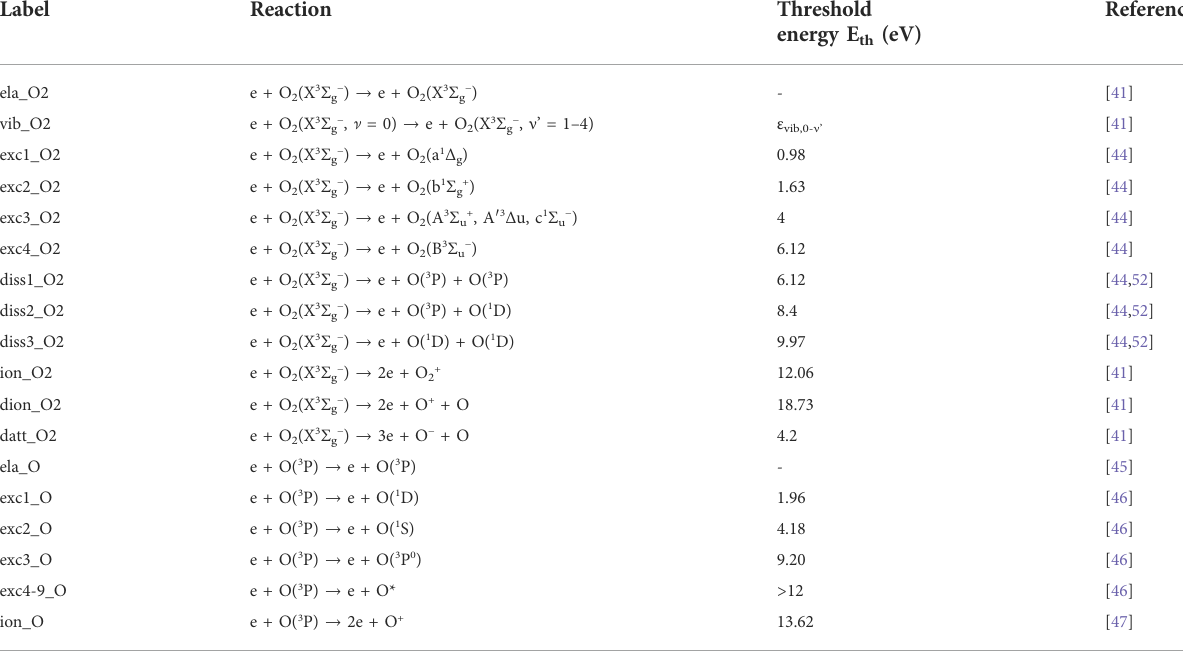
TABLE 3 Reactions between electron and the neutral oxygen species (O 2 and O) considered in the proposed PIC-TPMC model. Label